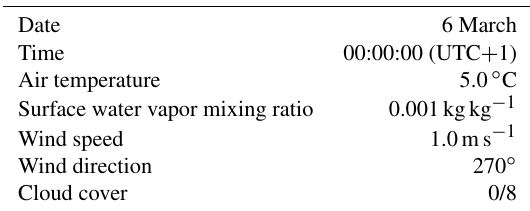
Figure 3. The site “test_urban” with shading as shown by the Sky- Helios model seen from south–southwest at 07:00UTC (shortly af- ter sunrise) on 6 March. Table 4. Overview over the meteorological initial conditions to run the test cases in